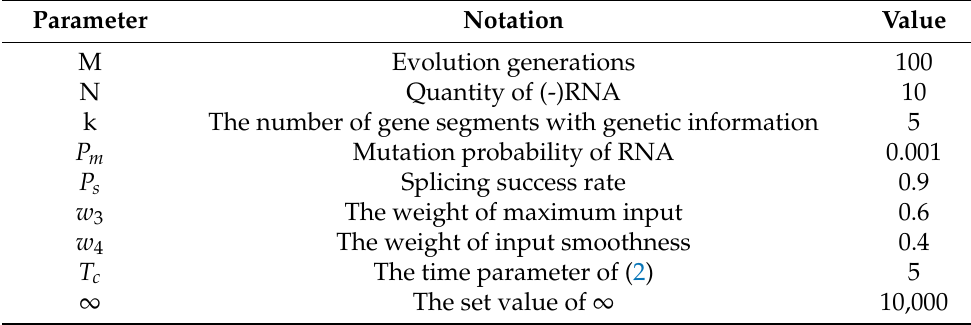
Table 3. The parameters of dsRNA Splicing Evolutionary